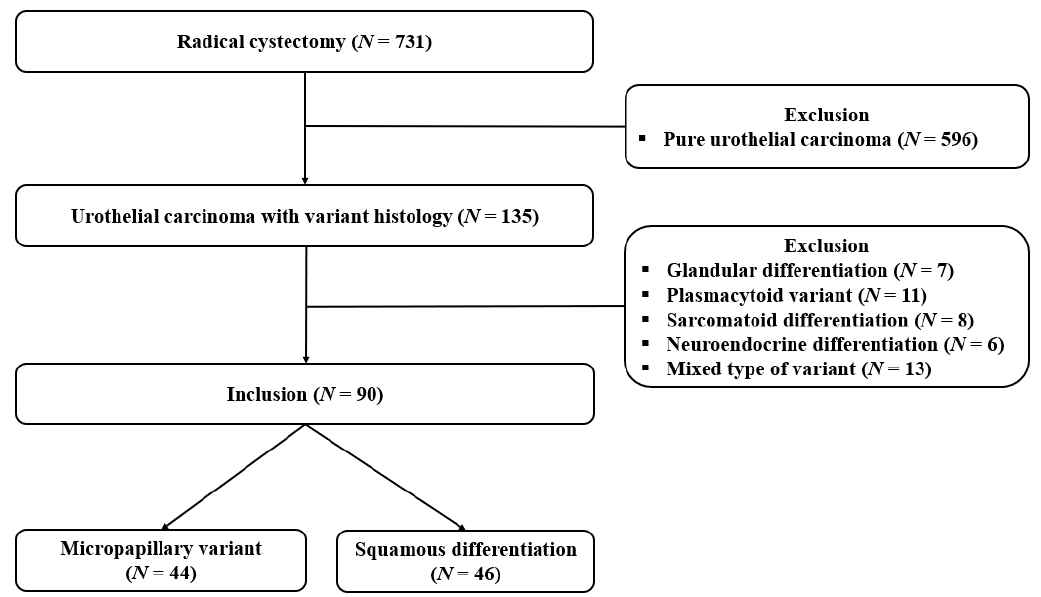
Figure 1. Flow chart of study inclusion.